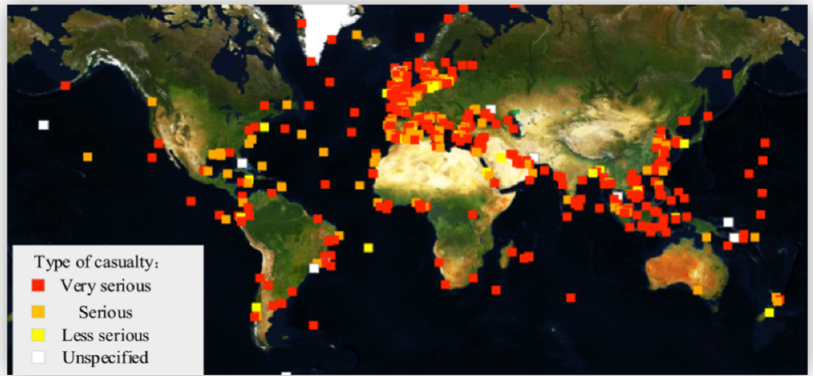
Figure 1. International Maritime Organization (IMO) Global Integrated Shipping Information System (GISIS) Statistics (from 1 January 2010 to 1 June 2019).